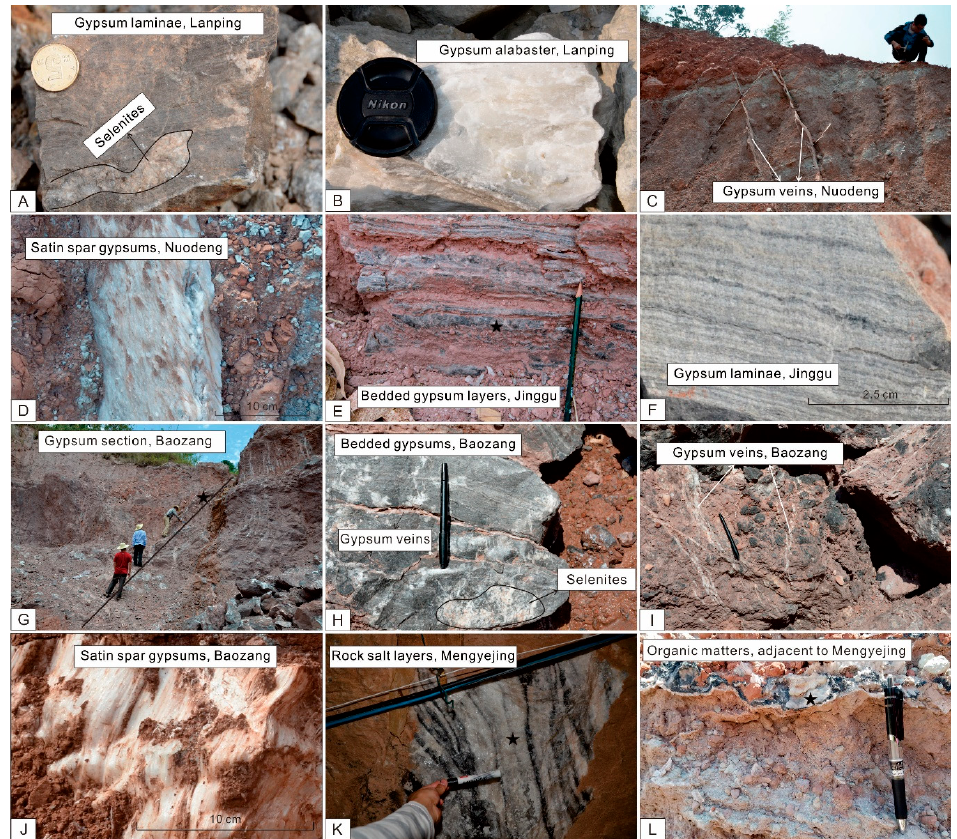
Figure 4. Characteristics of evaporites in the Lanping–Simao Basin. ( A ) Bedded gypsum layers in Lanping; ( B ) gypsum alabasters, Lanping; ( C ) gypsum veins within clastic rocks, Nuodeng; ( D ) satin spar gypsums, Nuodeng; ( E ) gypsum laminae, Jinggu; ( F ) millimetric gypsum layers (light color) interbedded with calcareous layer (dark grey color), Jinggu; ( G ) gypsum sections in Baozang; ( H ) gypsum laminae coexisting with selenite crystals, Baozang; ( I ) gypsum veins within mudstone breccias, Baozang; ( J ) satin spar gypsums intercalated with clastic rocks; ( K ) bedded rock salts in underground mine lane from Mengyejing; ( L ) organic matters within gypsum layers, adjacent to Mengyejing.